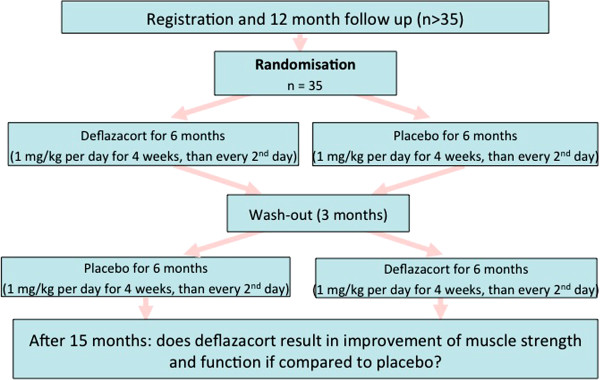
Flow chart of the clinical trial.